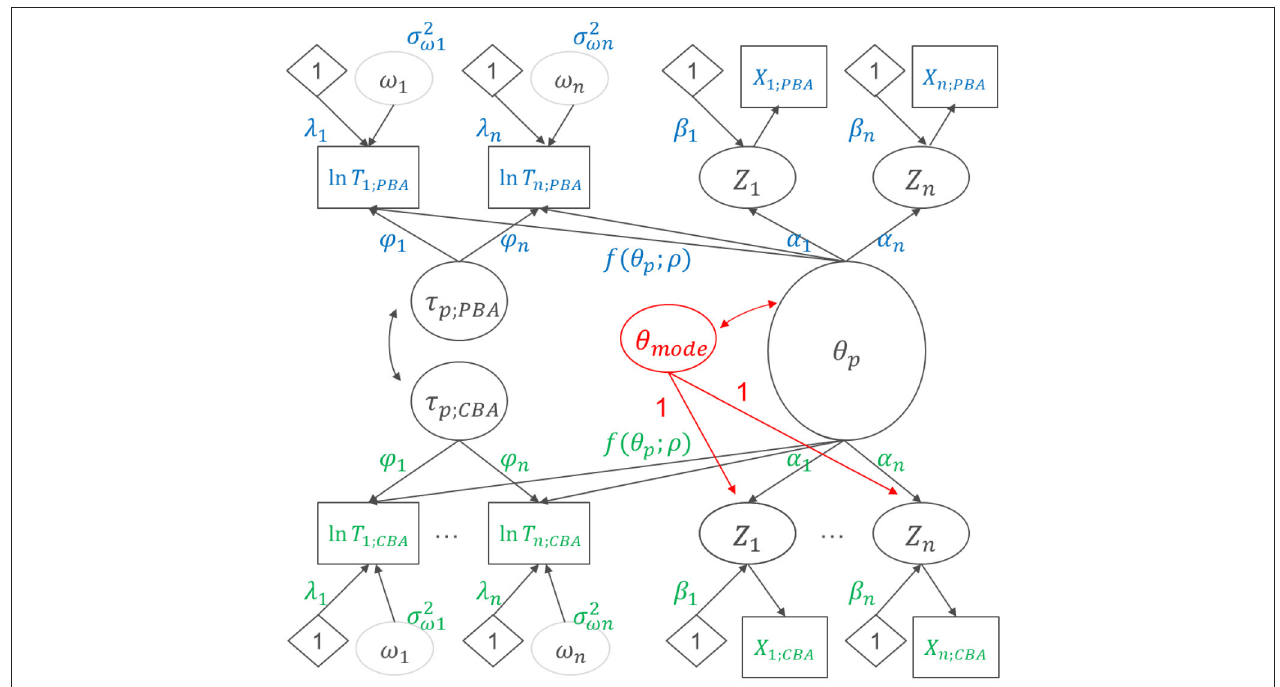
FIGURE 6 | Re-parameterized B-GLIRT model with a latent difference variable for inter-individual differences in the mode-effect and correlated, mode-specific speed factor.